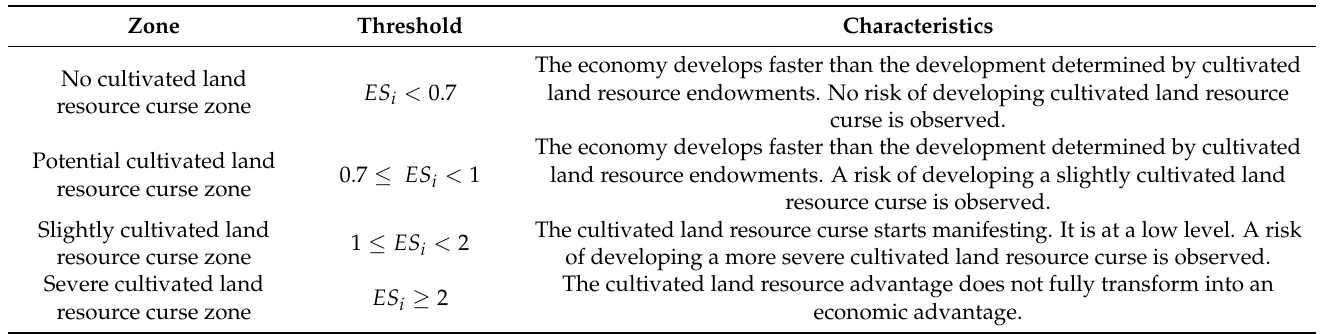
Table 1. Zoning thresholds and basic characteristics of the cultivated land resource curse. Zone Threshold